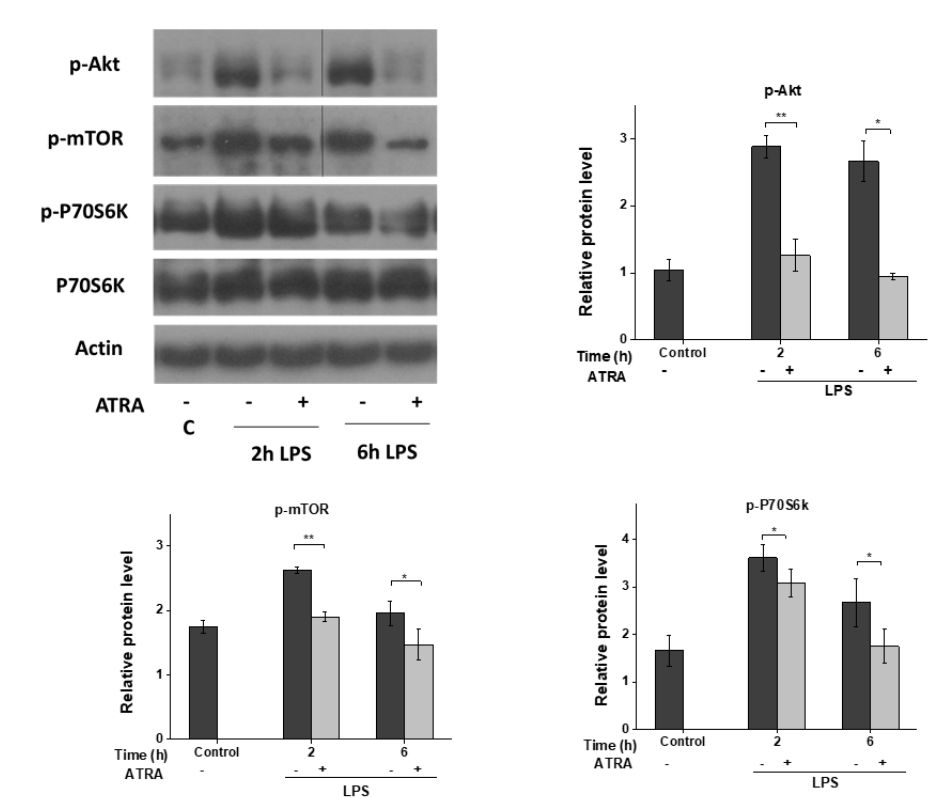
Figure 5. ATRA mediates signal transduction changes in M Φ s. Representative immunoblots of phosphorylated Akt, mTOR, P70S6K, and total P70S6K from whole-cell lysates. M Φ s were pre-incubated